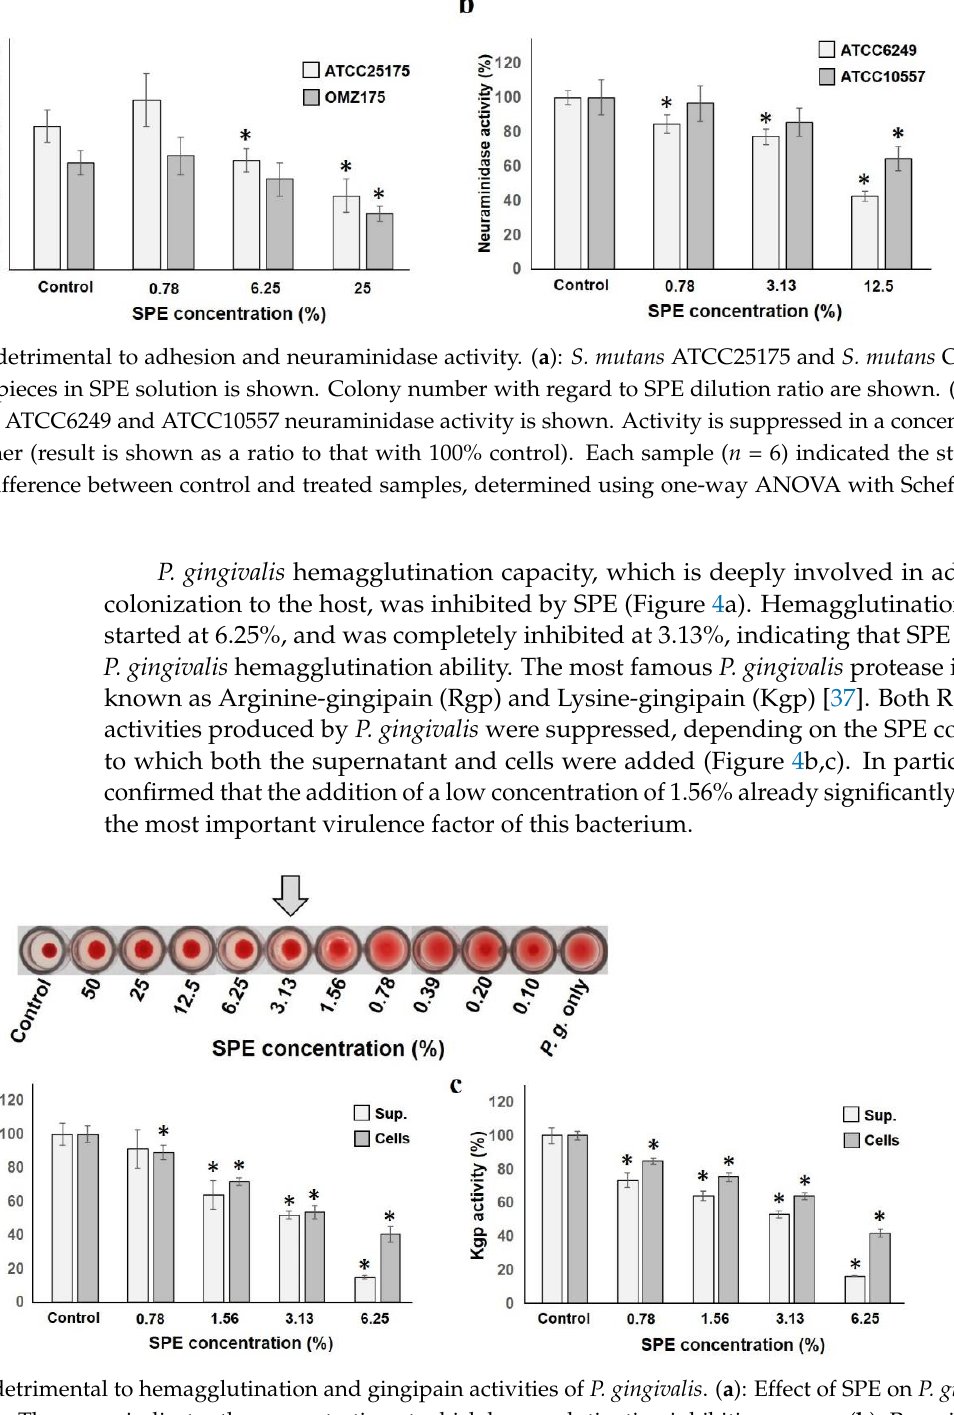
Figure 4. SPE is detrimental to hemagglutination and gingipain activities of P. gingivalis . ( a ): Effect of SPE on P. gingivalis hemagglutination. The arrow indicates the concentration at which hemagglutination inhibition occurs. ( b ): Rgp gingipain activity in culture supernatant or cells is shown as a ratio to that with 100% control. ( c ): Kgp gingipain activity in culture